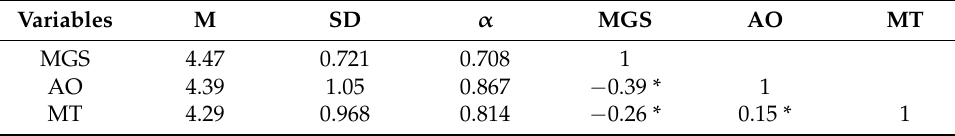
Table 1. Descriptive Statistics and Bivariate Correlations MGS, AO, and MT